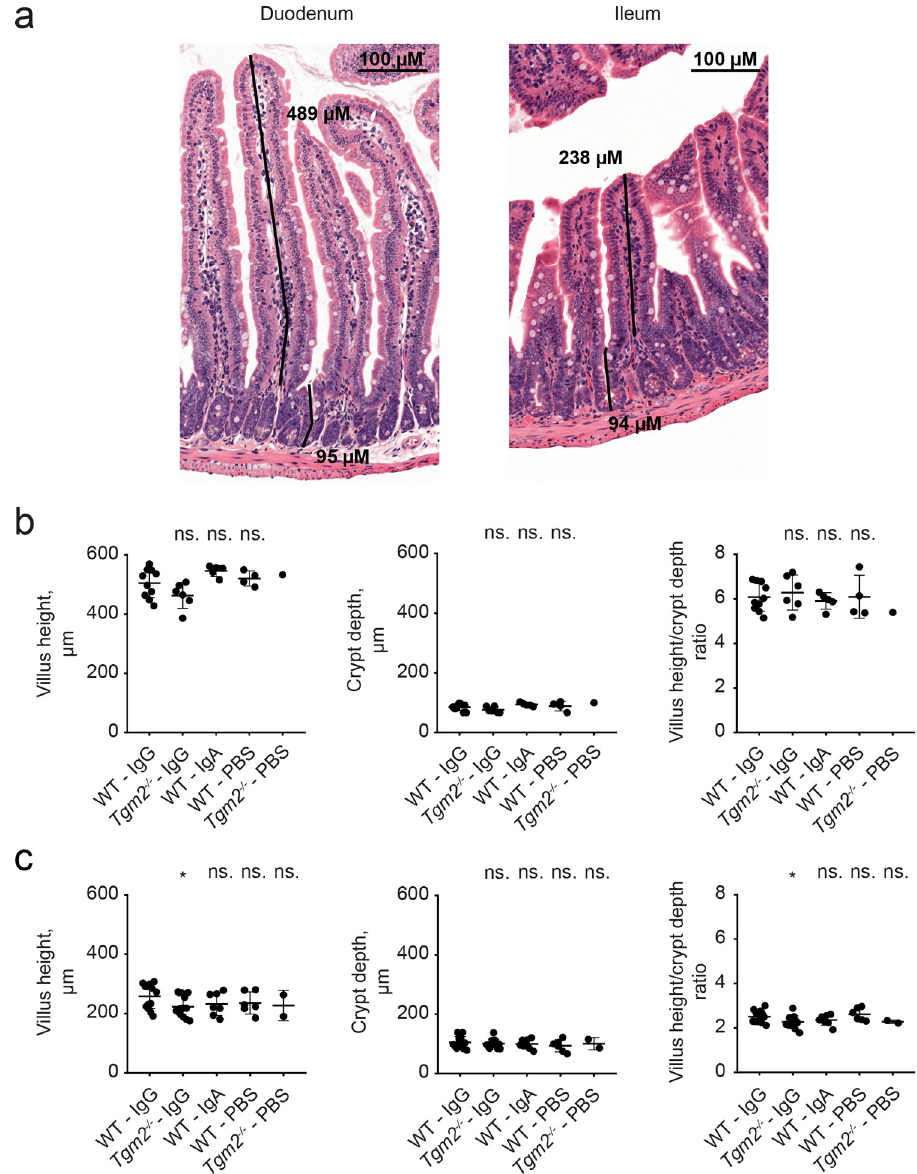
Fig 5. No difference in mucosal architecture between groups. (a) Examples of Vh and Cd measurements. Formalin- fixed paraffin-embedded samples stained with hematoxylin/eosin. Representative images show well-oriented pairs of villus and crypt from duodenum and ileum. Numbers indicate length of corresponding bars. (b, c) Vh, Cd and Vh/Cd ratio in duodenum (b) and ileum (c) of the different experimental groups. The WT IgG group was compared to each control group by individual Mann-Whitney tests. Data are pooled from two independent experiments. Bars represent mean +/- SD. � P � 0.05. n.s.: Not significant.